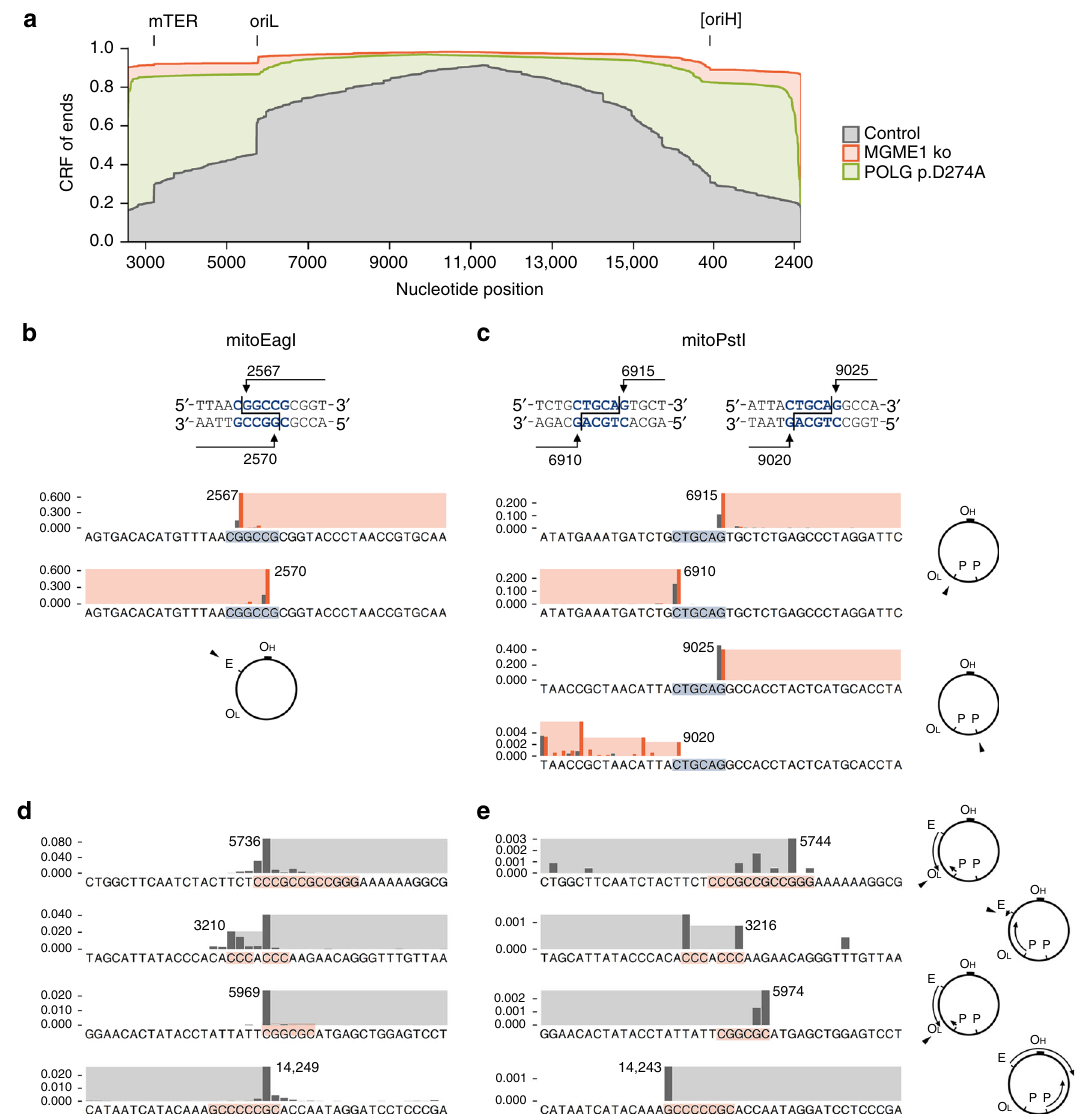
Fig. 3 Free mtDNA ends in HEK 293 cells expressing mitoEagI or mitoPstI. a Cumulative relative frequencies (CRF) of mtDNA ends detected by ultra-deep sequencing of linker-ligated mtDNA 6 h after induction of mitoEagI expression. CRF values for both orientations of ends were combined into a single curve. MGME1 knockout (red) results in persistence of non-degraded ends. In POLG p.D274A knockin cells (green), over 80% of ends are detected within a distance of 600 base pairs from the cutting site. Functionally relevant sites associated with prominent clusters of ends are marked on the top (mTER, mitochondrial transcription termination site; oriL, replication origin for the light strand; [oriH], replication origin region for the heavy strand). b , c Relative frequencies of blunt mtDNA ends at the vicinity of cutting sites detected by ultra-deep mtDNA sequencing 6 h after induction of mitoEagI ( b ) and mitoPstI ( c ). Balk heights represent proportions of ends at speci fi c nucleotide positions among all detected ends of the same orientation. Shadings indicate the retained part of mtDNA. Gray, control; red, MGME1 knockout in mitoEagI and MGME1 siRNA knockdown in mitoPstI. Blue shading indicates mitoEagI and mitoPstI recognition sites (schematically shown on the top). d , e Frequent mtDNA ends distal to the cutting sites as observed by ultra-deep mtDNA sequencing 6 h after induction of mitoEagI ( d ) or mitoPstI ( e ) in control cells. Shaded areas indicate the retained mtDNA fragment. Associated GC stretches are indicated by red shading (at least 3 consecutive Gs or Cs starting at less than 3 nucleotides difference from the end). Note that prominent ends are located at different sides of the same GC stretch depending on the main direction of degradation in mitoEagI-expressing and mitoPstI-expressing cells (indicated by arched arrows in the schemes on the side). The presence of non-degraded and selected partially degraded ends was con fi rmed by single-molecule PCR (Supplementary Fig.